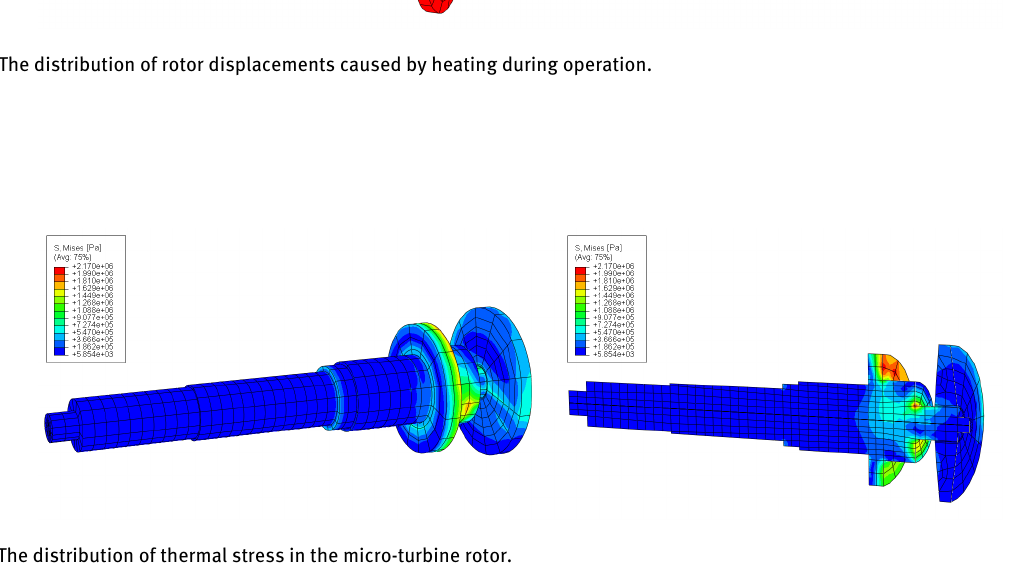
Figure 5: The distribution of thermal stress in the micro-turbine rotor.